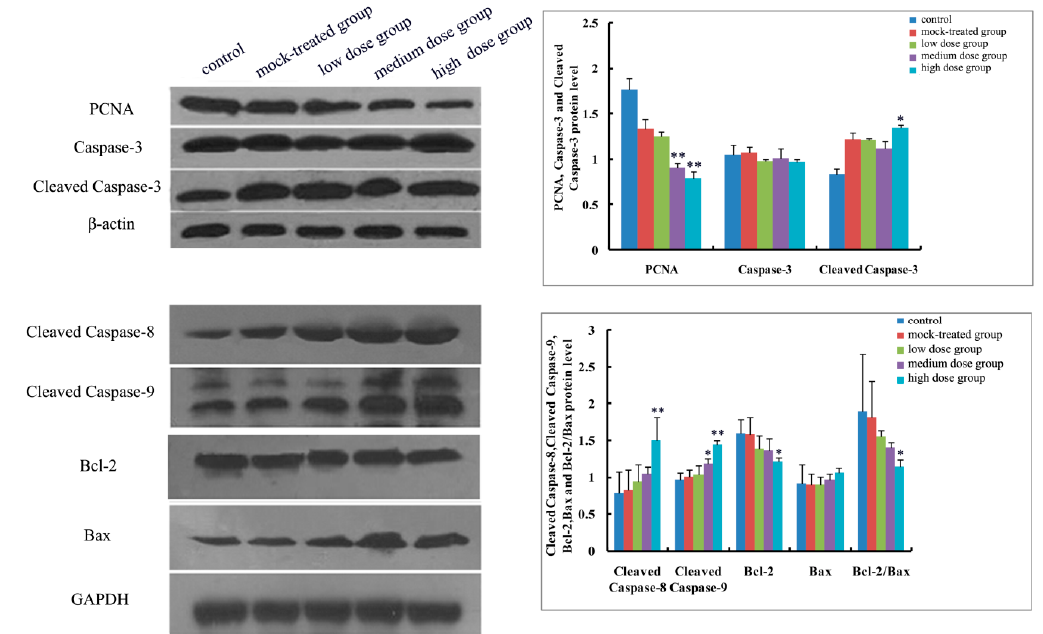
Figure 6. Expressions of apoptosis-related proteins (Caspase-3, Cleaved Caspase-3, Cleaved Caspase-8, Cleaved Caspase-9, Bcl-2, Bax, and Bcl-2/Bax) and PCNA in cerebral cortex of mice offspring on postnatal day 7 after maternal exposure to PM 2.5 during pregnancy. Left: the results of Western blot; Right: histogram of relative protein levels. * p < 0.05, compared with control; ** p < 0.01, compared with control.